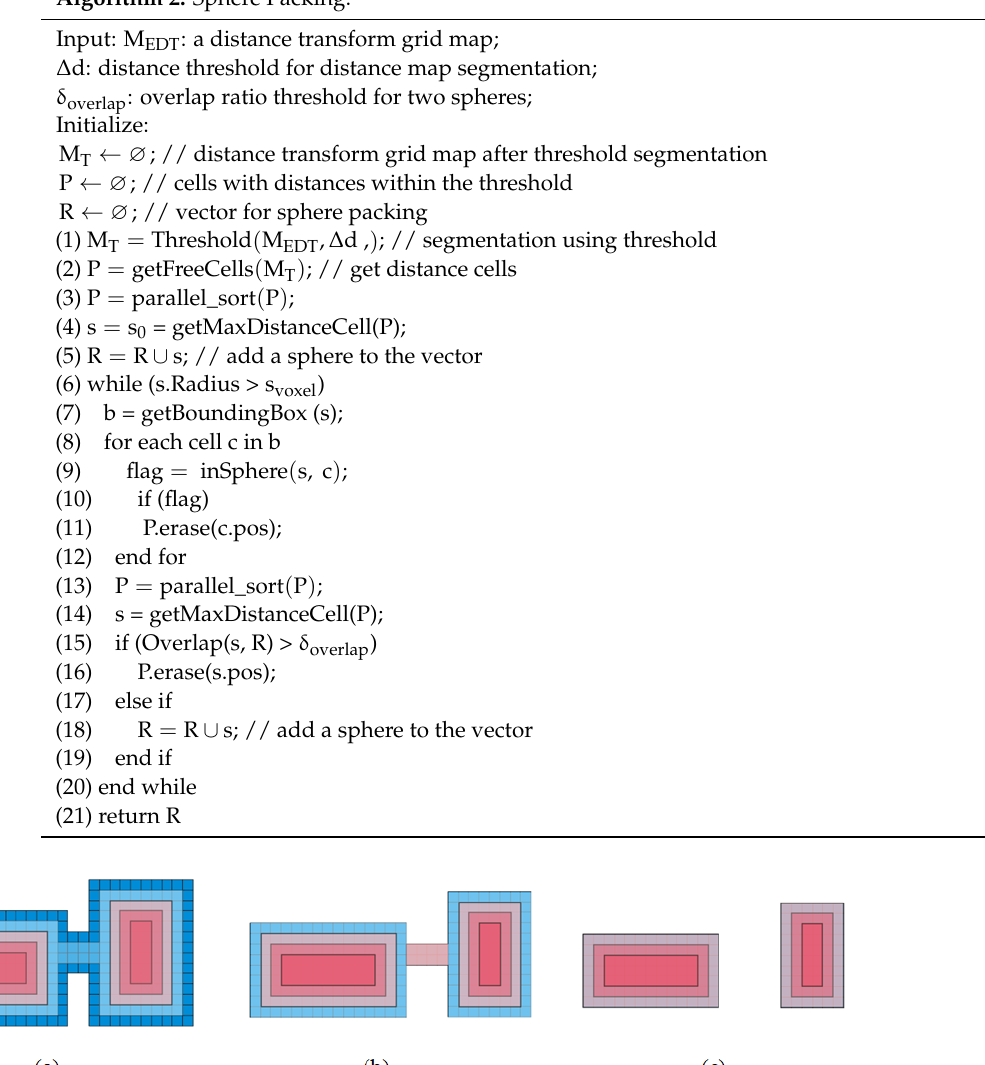
Algorithm 2. Sphere Packing.